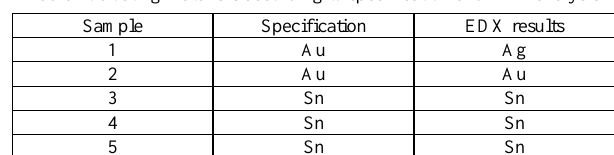
Table 1. Coating materials according to specification and EDX